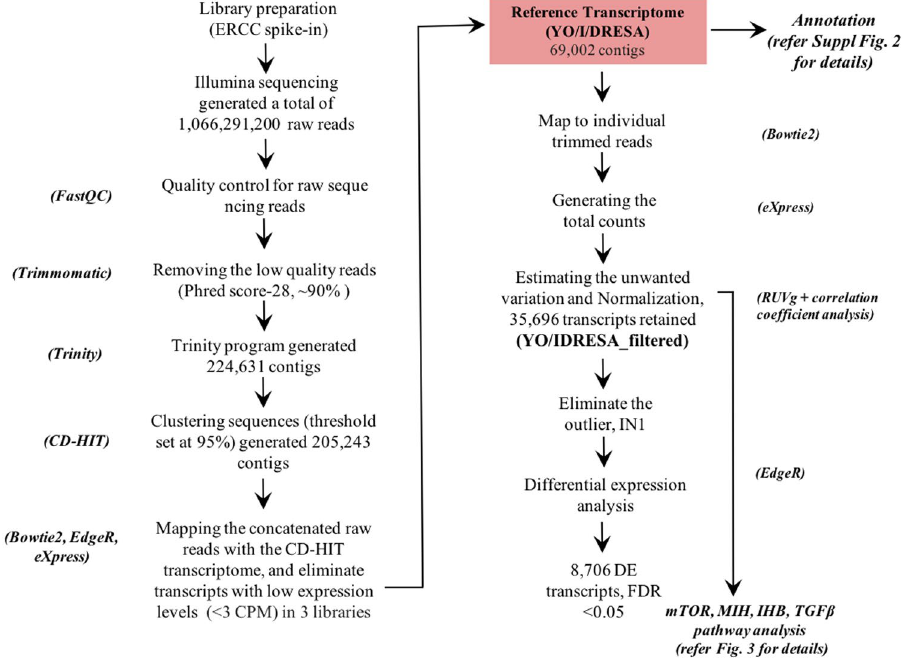
Figure 2. De novo assembly pipeline for G . lateralis YO/IDRESA transcriptome. The software required for assembling raw reads from Illumina sequencing, data evaluation, de novo assembly, estimation of transcript abundance, and contig annotation are indicated in italics. A detailed description of the software pipeline is provided in the Methods section and Supplementary